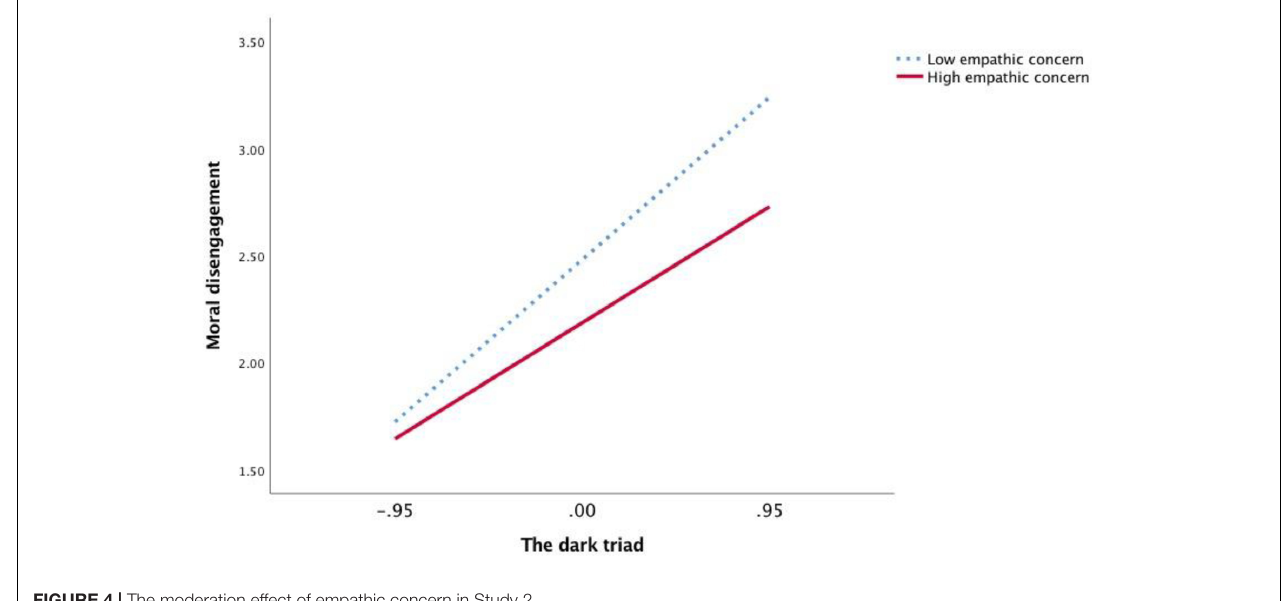
FIGURE 4 | The moderation effect of empathic concern in Study 2.